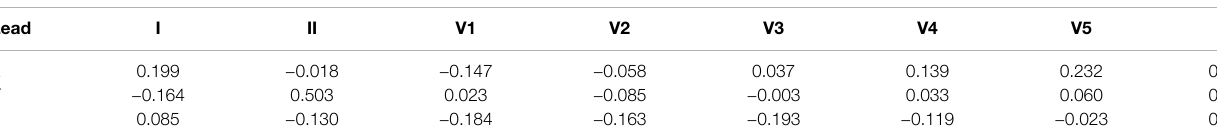
TABLE 6 | QLSV transformation matrix.